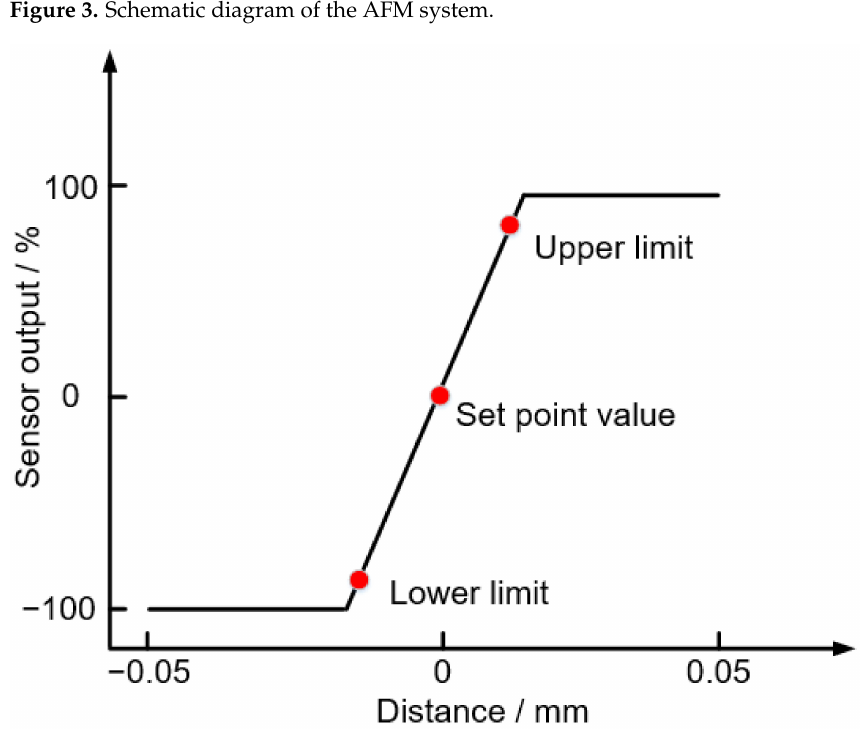
Figure 4. Typical characteristic curve of an